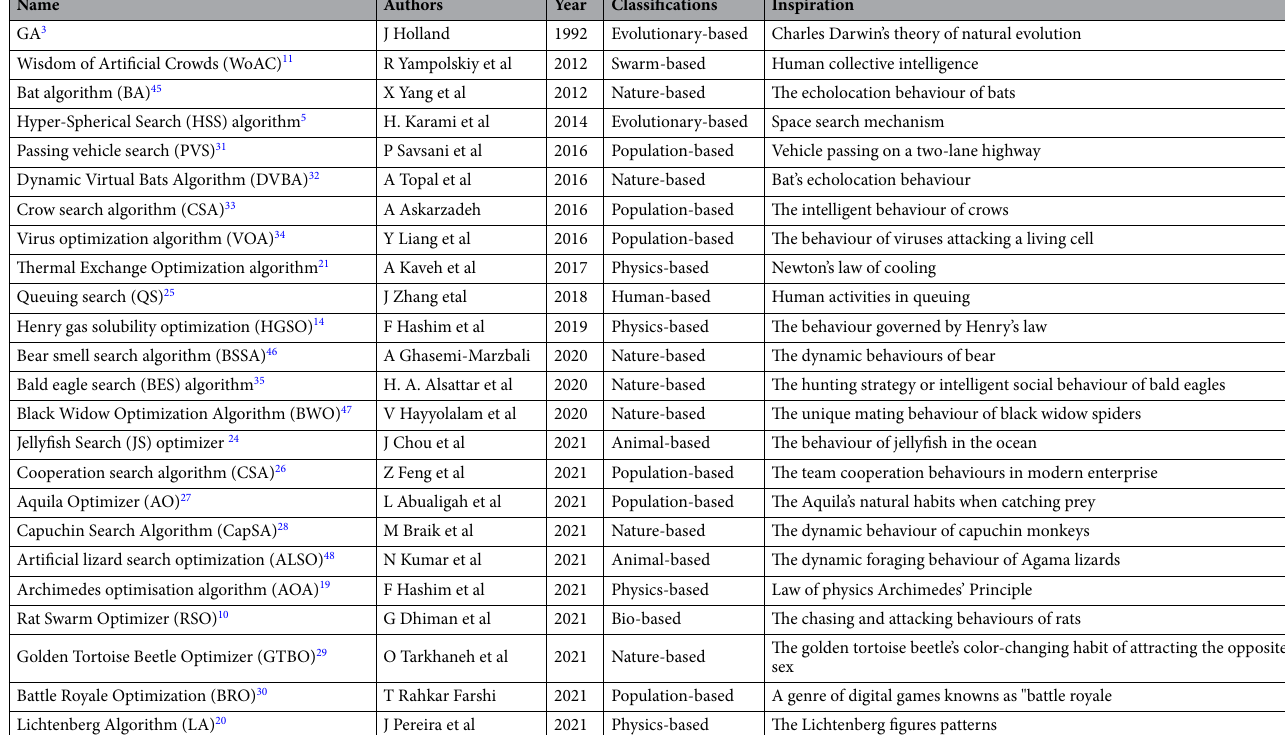
Table 1. Historical to cutting-edge metaheuristic optimization